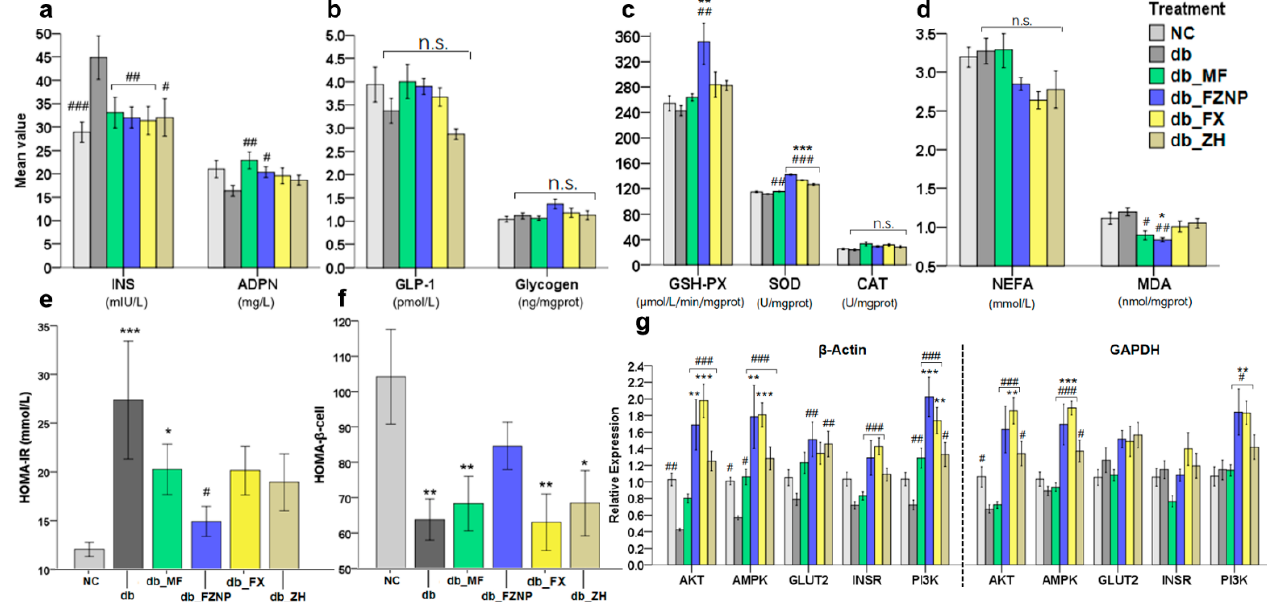
Figure 4. Indicators of blood, insulin and glucose metabolism in serum as well as liver tissue and gene expression measured by qPCR. The levels of INS/ADPN ( a ), GLP-1/Glycogen ( b ), glutathione peroxidase (GSH-Px) activity, superoxide dismutase (SOD) activity and catalase (CAT) activity ( c ), non-esterified free fatty acids (NEFA) and malondialdehyde (MDA) ( d ), HOMA-IR ( e ), and HOMA- β ( f ), expression of AKT, AMPK, GLUT2, INSR and PI3K genes in the liver with β -Actin (right part) and GAPDH (left part) as internal reference ( g ). The asterisk including * ( p < 0.05), ** ( p ≤ 0.01), and *** ( p ≤ 0.001) indicate the significant difference compared with the NC group. The hashes including # ( p < 0.05), ## ( p ≤ 0.01) and ### ( p ≤ 0.001) indicate the significant difference from the db